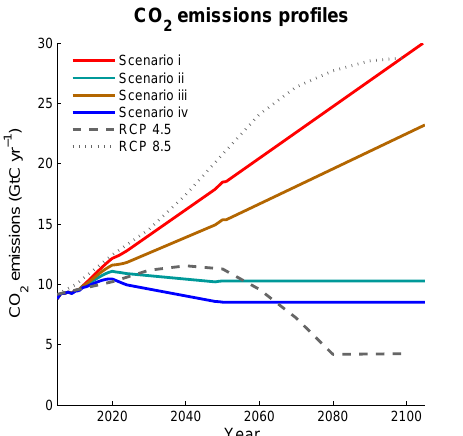
Figure 3. Total CO 2 emissions associated with four different elec- tricity sector-only policy scenarios. Total CO 2 emissions associated with two RCPs are shown for reference. (Note that the RCP scenar- ios cover all sectors and land